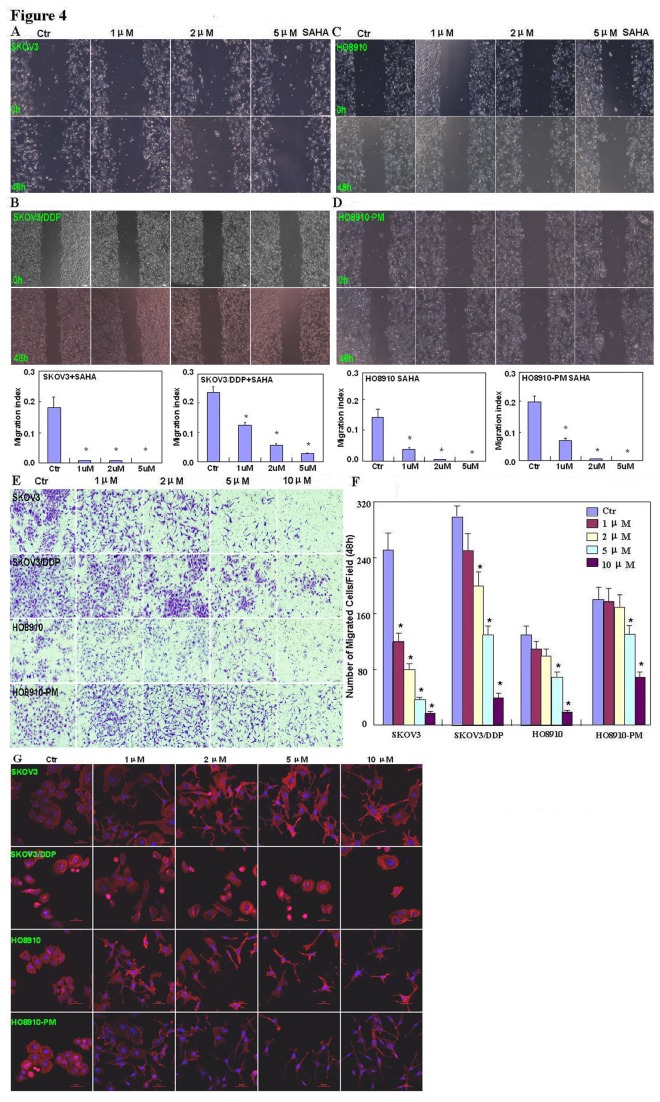
Effects of SAHA on the invasive ability of ovarian carcinoma cells.Wound healing assays showing that SAHA treatment decreases the ability of SKOV3 (A), SKOV3/DDP (B), HO8910 (C) and HO8910-PM (D) cells to migrate in a concentration-dependent manner(n=9); and reduces the invasive potential(E&F,n=3) and suppressed lamellipodia formation(G) of SKOV3, SKOV3/DDP, HO8910 and HO8910-PM cells.